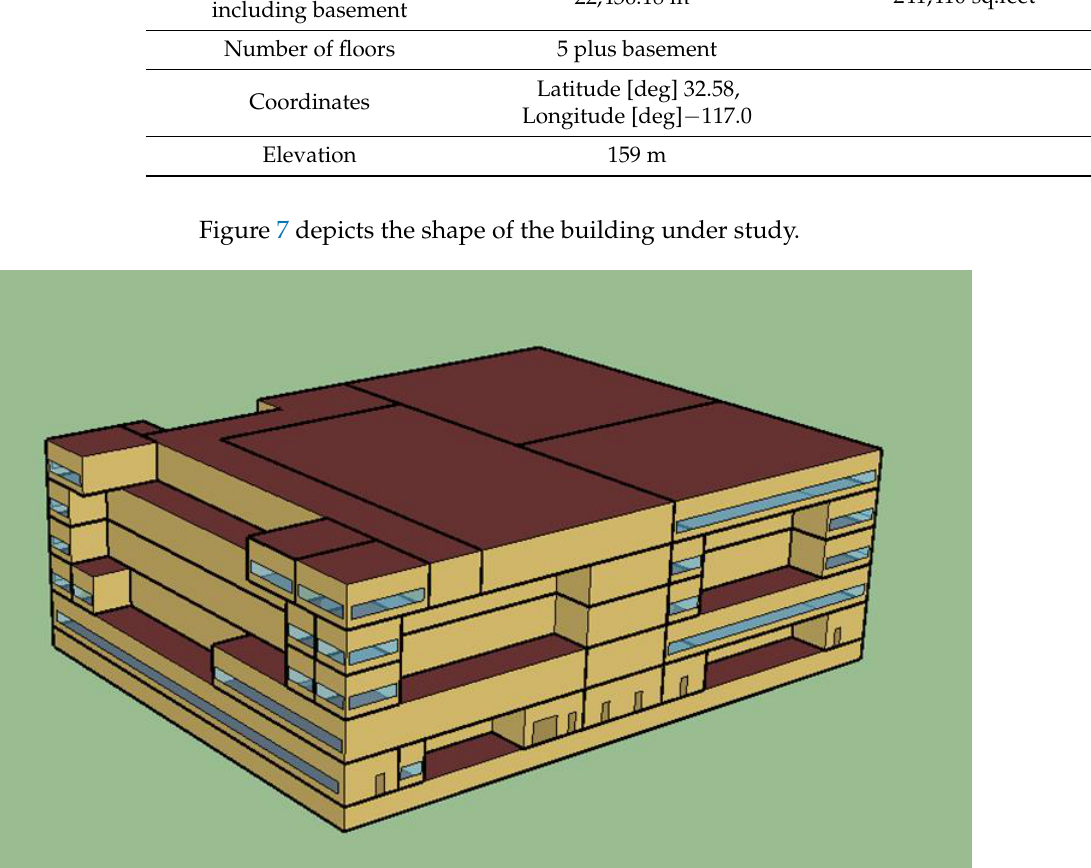
Figure 7. The shape of the reference